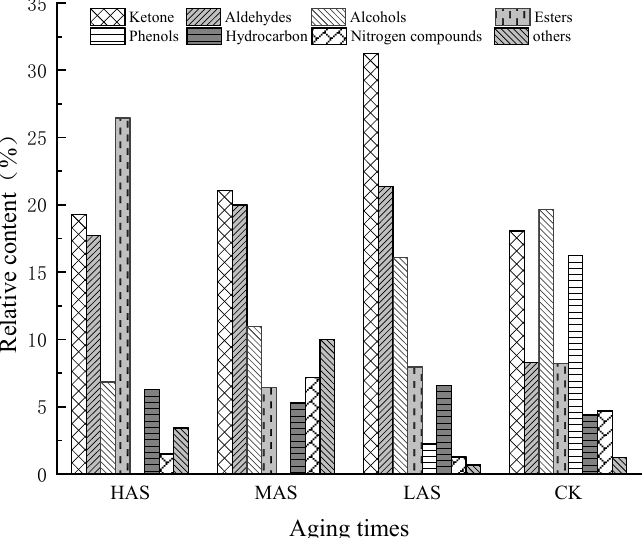
Figure 1. Relative contents (%) of eight types of volatile compounds detected in samples of An–tea with different aging times.